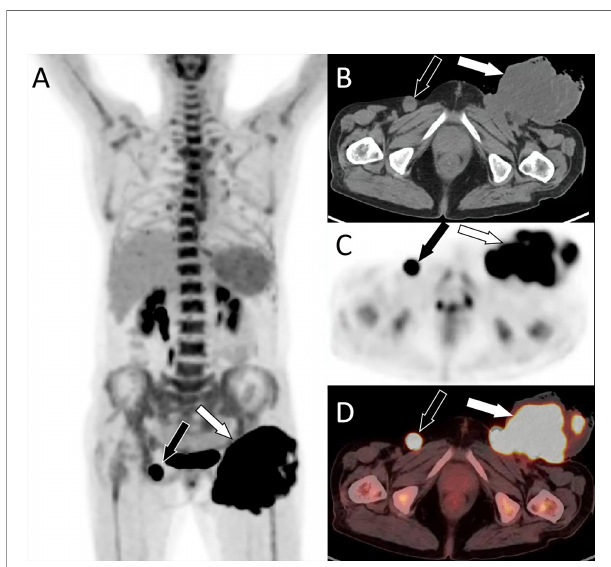
FIGURE 2 | PET/CT examination. (A) Whole-body MIP images showed a lumpy hypermetabolic lesion in the left groin (white arrow) and increased nodular uptake of FDG in the right groin (black arrow). (B) Axial CT shows an uneven low-density mass in the left groin (white arrow) and a rounded soft tissue density nodule in the right inguinal region (black arrow). (C) PET and (D) PET/CT fusion images show a hypermetabolic mass in the left groin area with SUVmax of 31.38 (white arrow) and nodules in the right groin area with radioactive uptake with SUVmax of 28.0 (black arrow). MIP, maximum intensity projection; FDG, fl uorodeoxyglucose; PET, positron emission tomography; CT, computed tomography; SUVmax, maximum standard